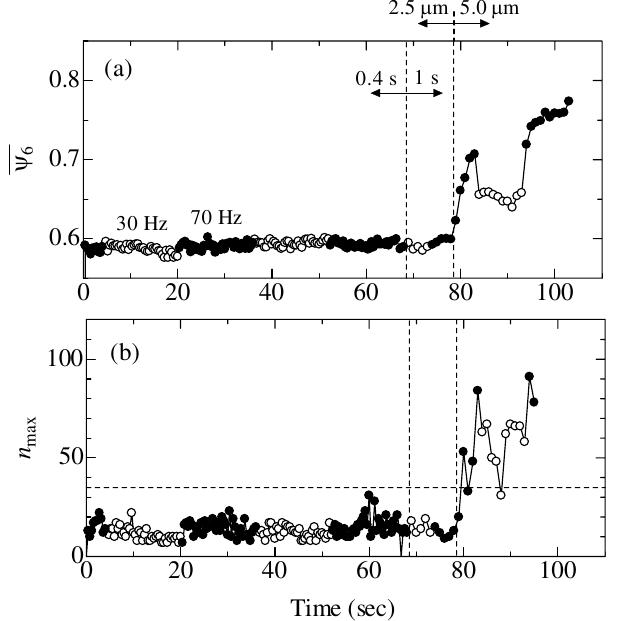
Figure 4. Evolutions of ( a ) ψ and ( b ) n max when 30 and 70 Hz oscillations were applied alternately. Vertical 6 dashed lines denote where oscillation time and amplitude were changed. A horizontal dashed line in ( b ) indicates n max =